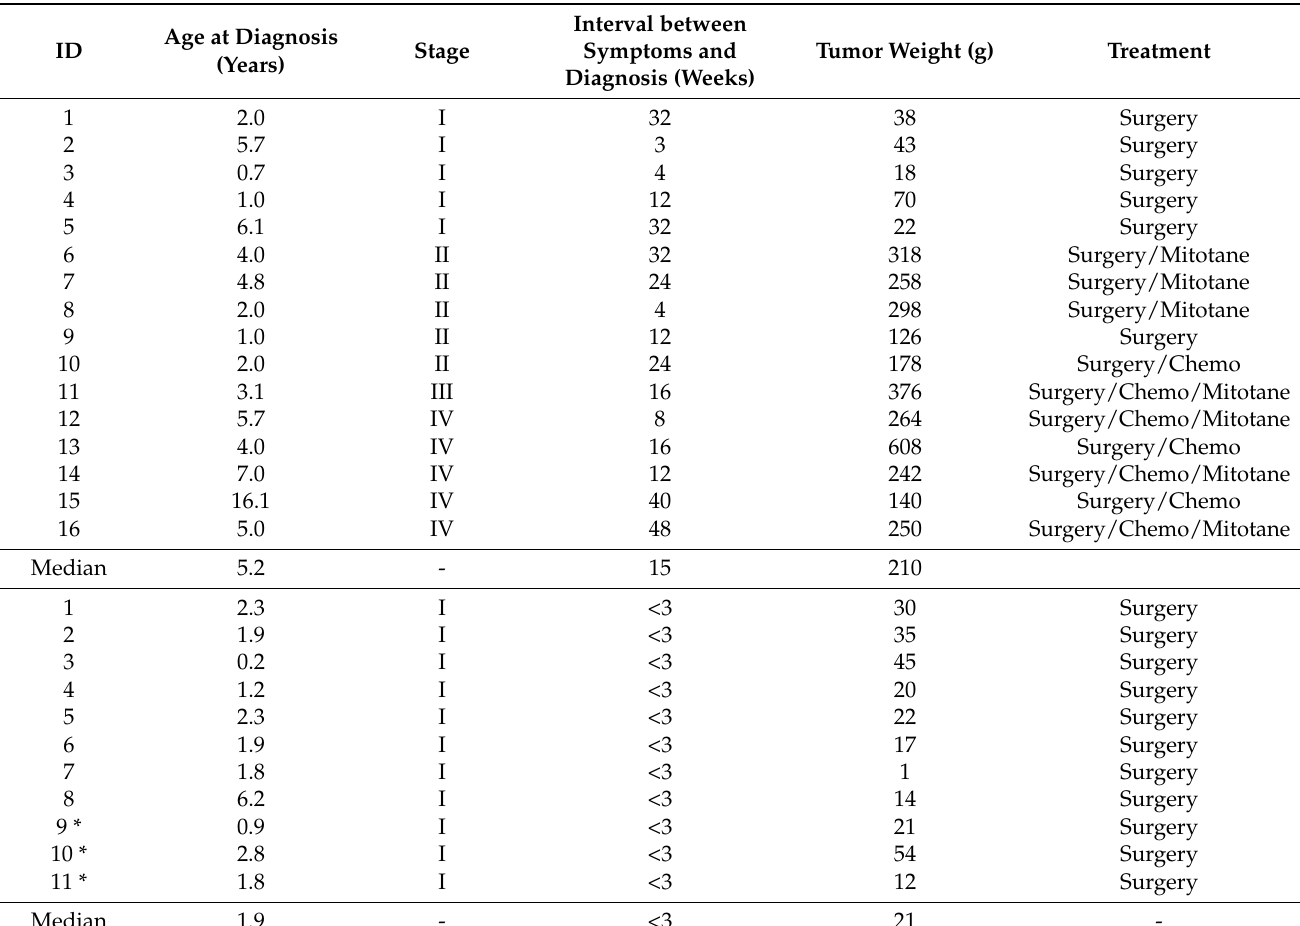
Table 1. Upper: features of cases admitted to a single hospital between 2011 and 2019 (non-NSS); Lower: features of participants in newborn screening and who had tumor detected by surveillance